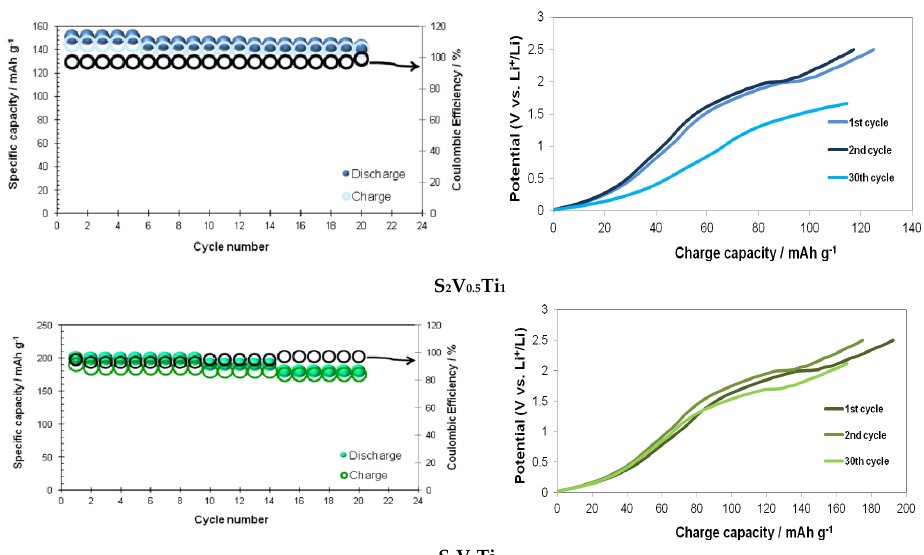
Figure 6. Galvanostatic charging and discharging with the system V x O y -TiO 2 -rGO|Li at 50 mA g − 1 . The electrode material is a composite and therefore the capacities given have not been corrected for the vanadium oxide content. It was observed that, after 120 cycles (S 2 V 0.5 Ti 1 ) at higher current Table 3. Rate performance under various current densities of VxOy-TiO 2 density, the prepared material still shows an impressive discharge capacity of ~ 118 mAh g − 1 at a current density of 500 mA g − 1 (Table 3). All samples show relatively good capacity retention after cycles with gradually increasing currents. One may notice that S 2 V 1 Ti 1 shows reversible capacities of about 182 mAh g − 1 at 50 mA g − 1 (Figure 6), and this value drops to 120 mAh g − 1 . The specific capacity is low-suggesting that lithium incorporation is limited under these conditions and that surface vanadate oxides do not significantly improve ion diffusion at the